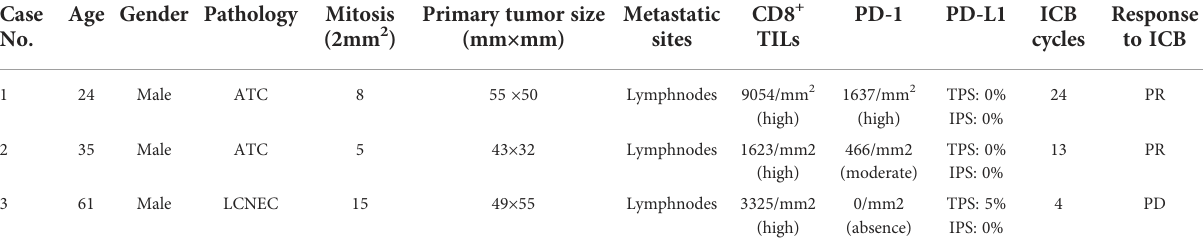
TABLE 5 Characteristics of the patients received ICB treatment. Case